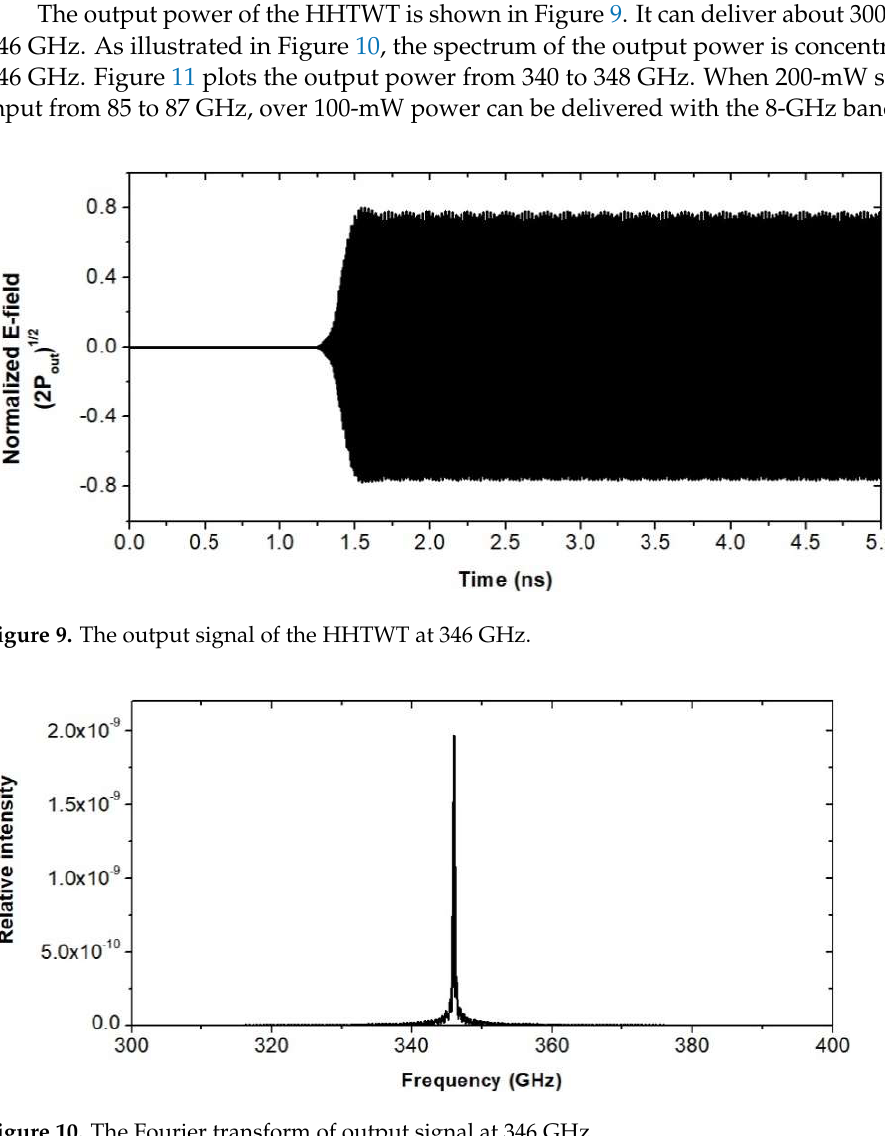
Table 2. Parameters of the HHTWT.